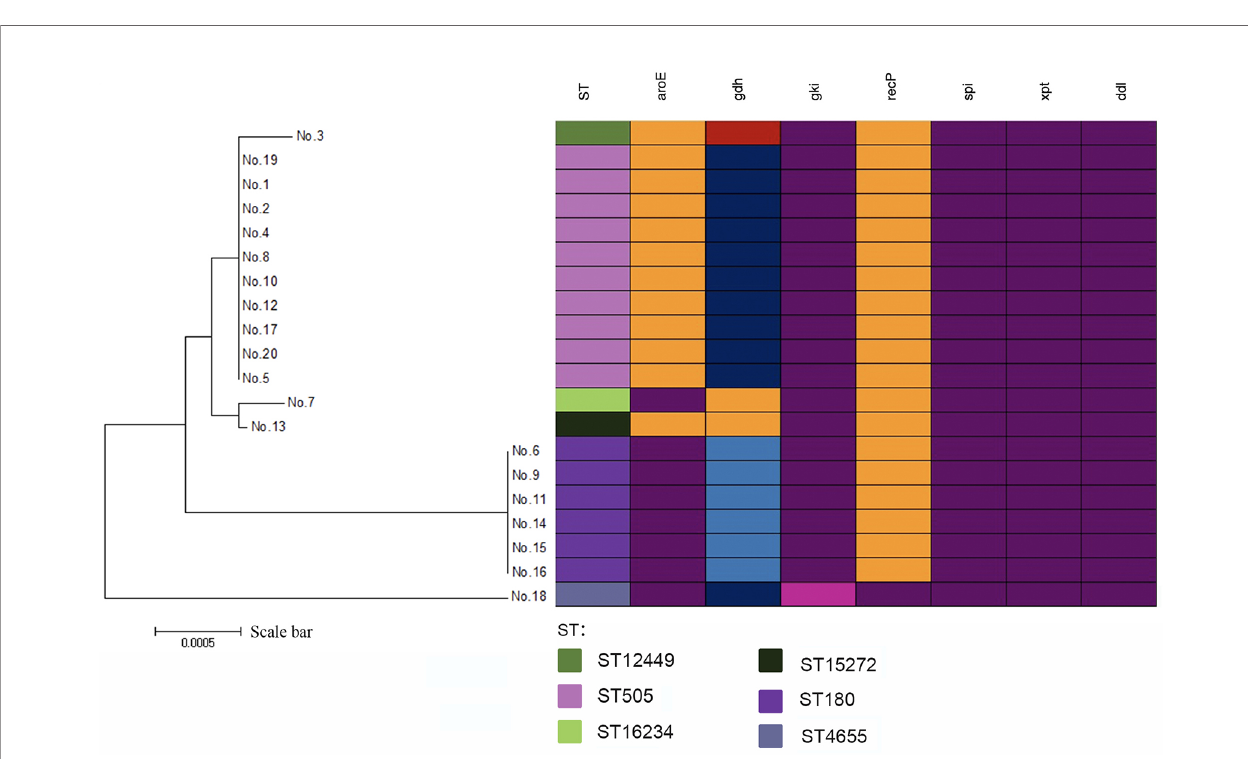
FIGURE 2 | A minimum evolutionary tree of 20 mucoid serotype 3 S. pneumoniae isolates. The farther the straight distance was, the greater the gene sequence gap between isolates was. Mutations in alleles were shown by different colors.